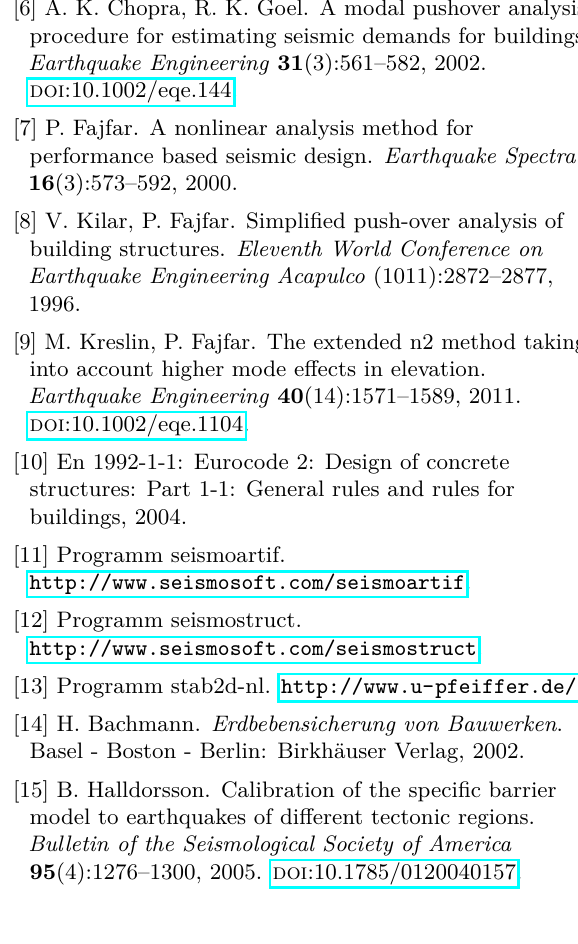
Table 3. Comparison of calculations of the seismic